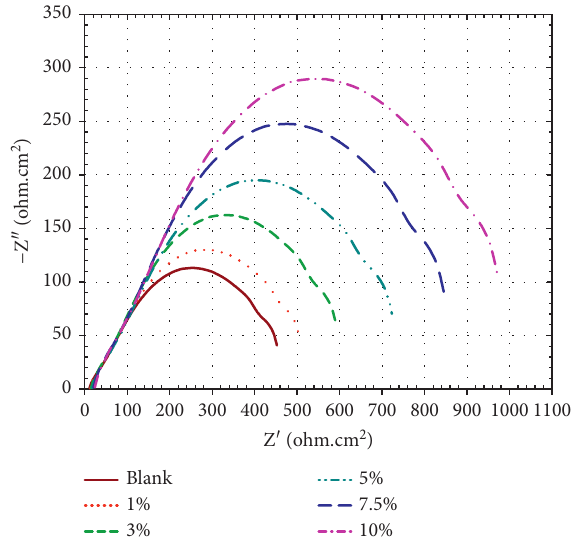
Figure 3: Nyquist plots for the steel alloy 4130 sample engrossed in 3.5 wt.% NaCl electrolyte and diverse loads of